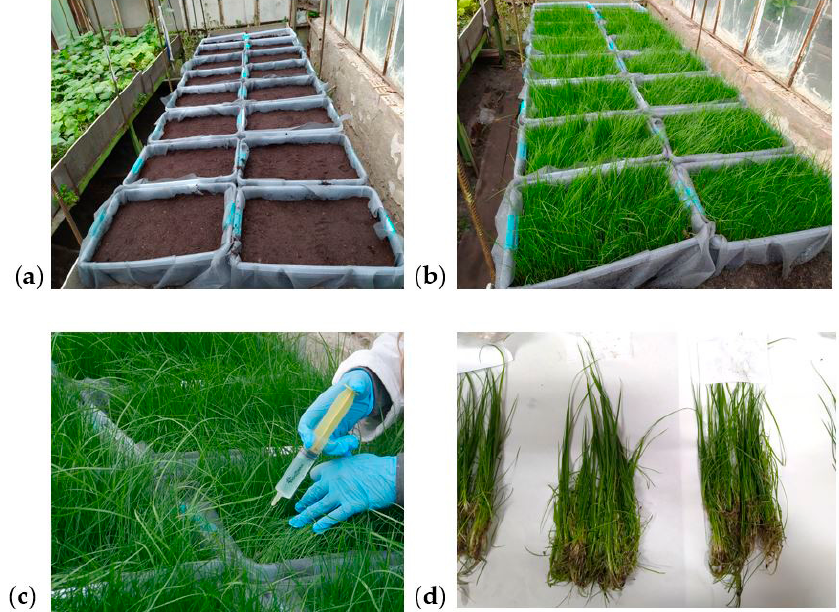
Figure 1. The stages of the conducted experiment: ( a ) preparation of soil for seed sowing; ( b ) growth of the lawn grass; ( c ) insertion of the metal solutions; ( d ) preparation of grass samples for analysis.